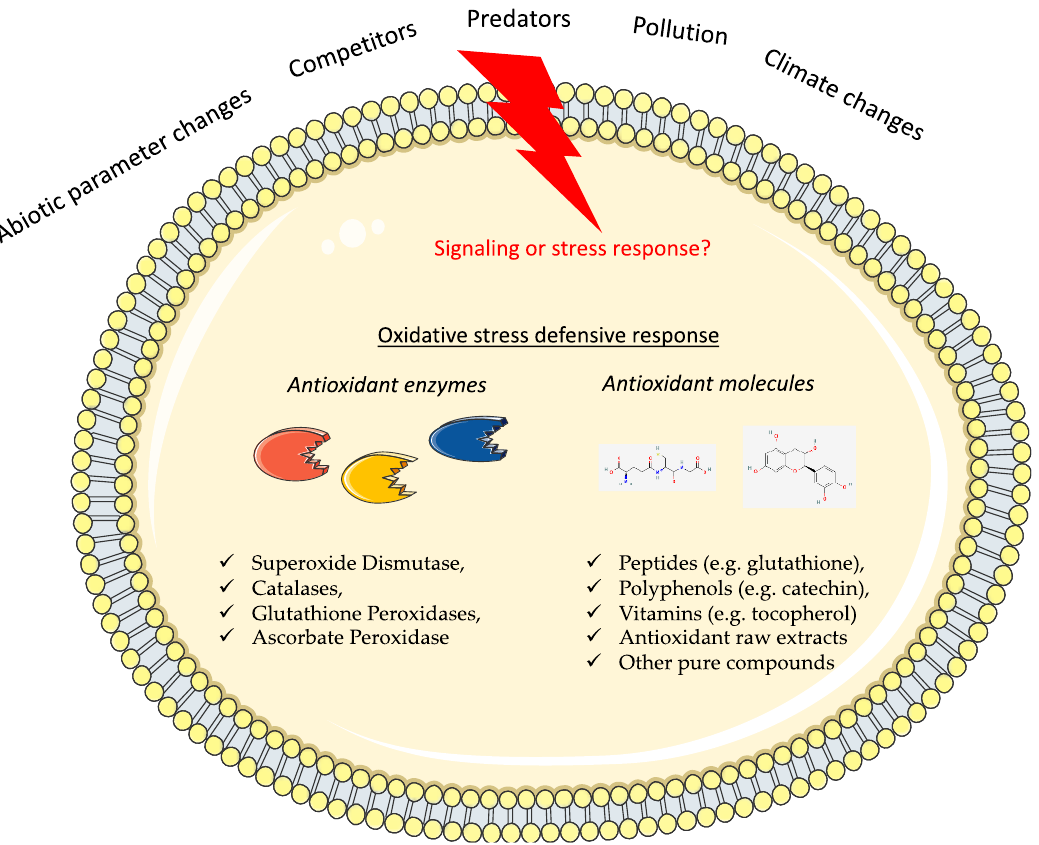
Figure 1. Schematic representation of enzymatic and non-enzymatic defense strategies, reporting some examples of oxidative stress inducers, as well as examples of antioxidant enzymes and molecules.